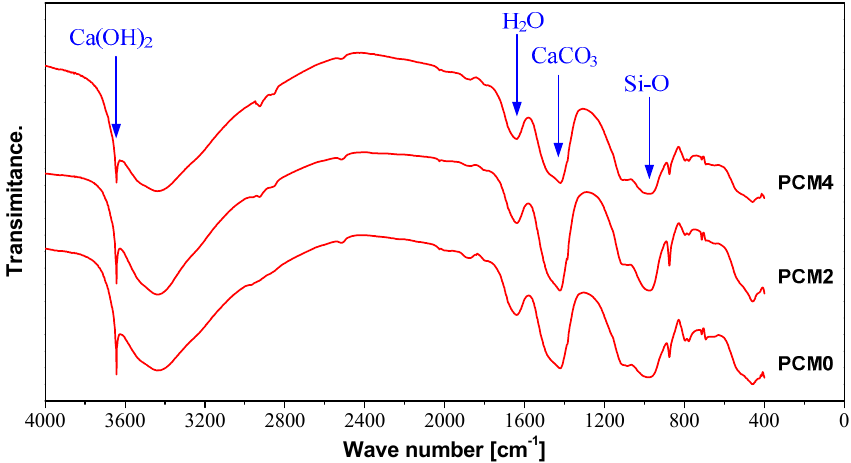
Figure 10. Fourier transform infrared spectroscopy (FTIR) analysis of cement mortar with di ff erent PVA content.